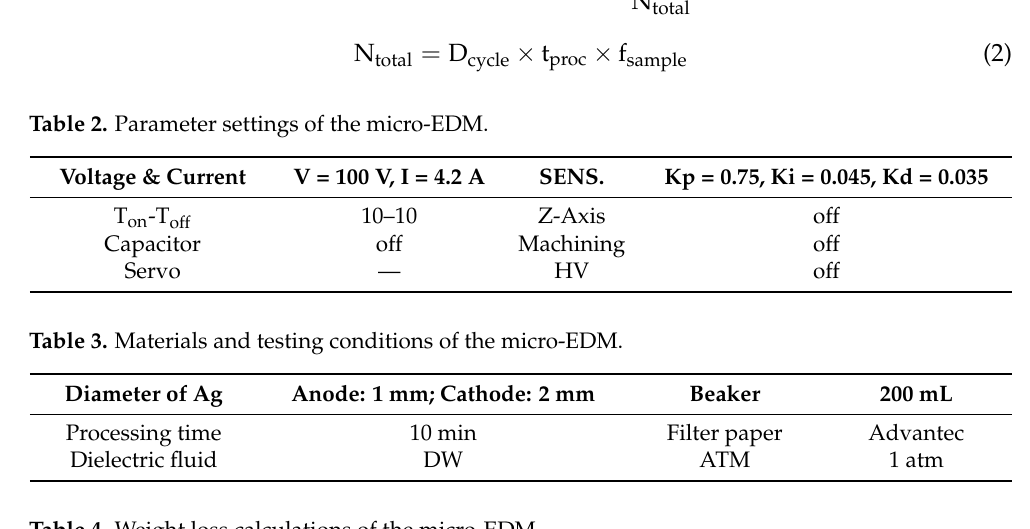
Table 4. Weight loss calculations of the micro-EDM.